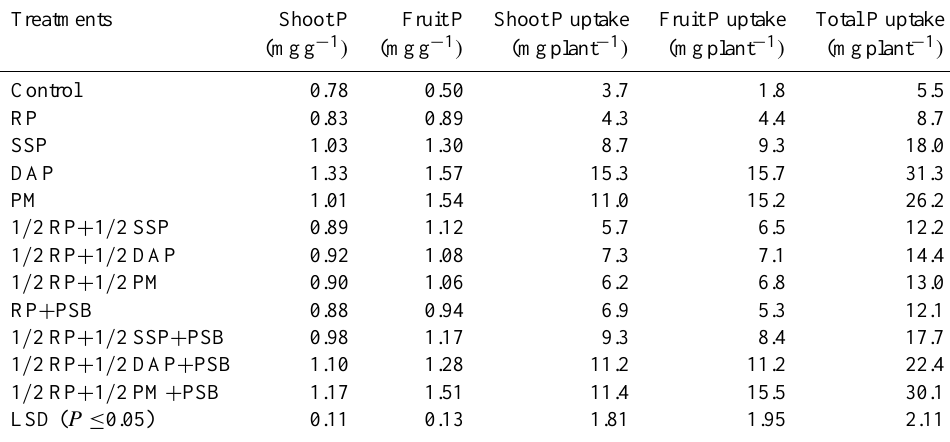
Table 5. Effect of soluble P fertilizers and insoluble rock phosphate (RP) applied alone or in combination with phosphate-solubilizing bacteria (PSB) and poultry manure (PM) on P content and P uptake of chilli ( Capsicum annuum L.) grown in pots under greenhouse conditions at Rawalakot Azad Jammu and Kashmir. Treatments Shoot P Fruit P Shoot P uptake Fruit P uptake Total P uptake (mgg − 1 ) (mgg − 1 ) (mgplant − 1 ) (mgplant − 1 ) (mgplant − 1 ) Control 0.78